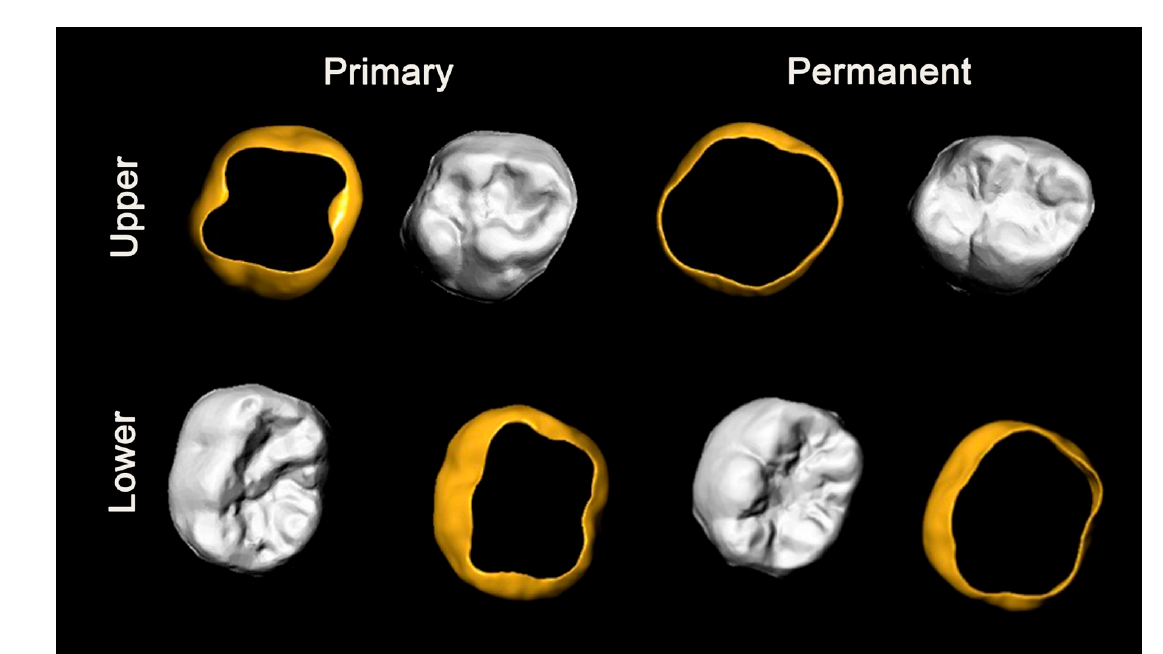
Figure 4. Morphological comparison between primary and permanent molars and the design of the respective orthodontic bands.